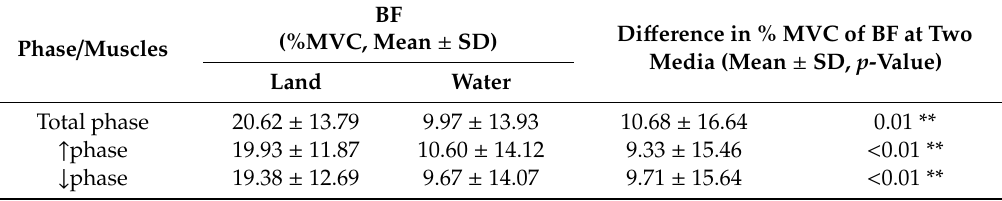
Table 4. The comparison of BF muscle activity at di ff erent media at di ff erent squatting phases. BF Phase / Muscles